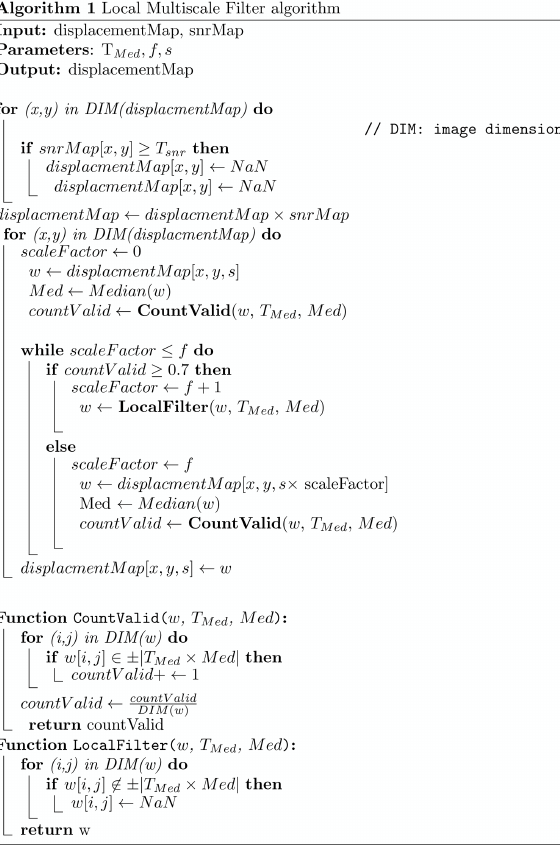
Algorithm for the post-processing of displacement